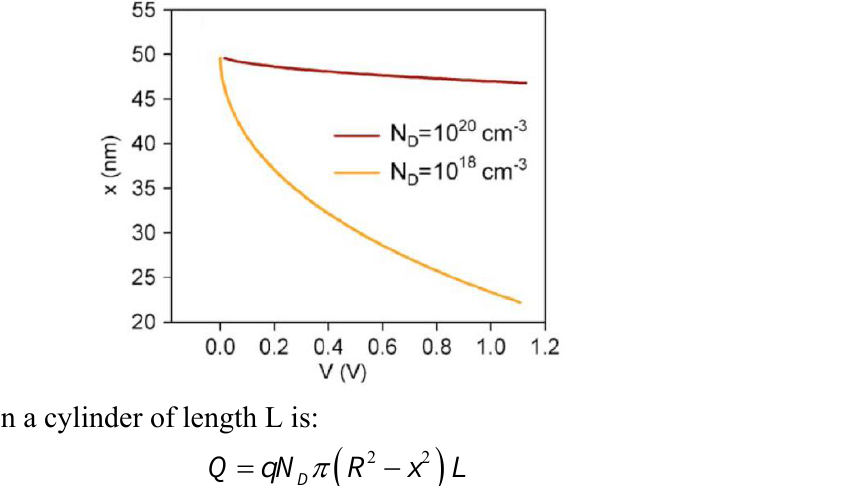
= 10, for two different r